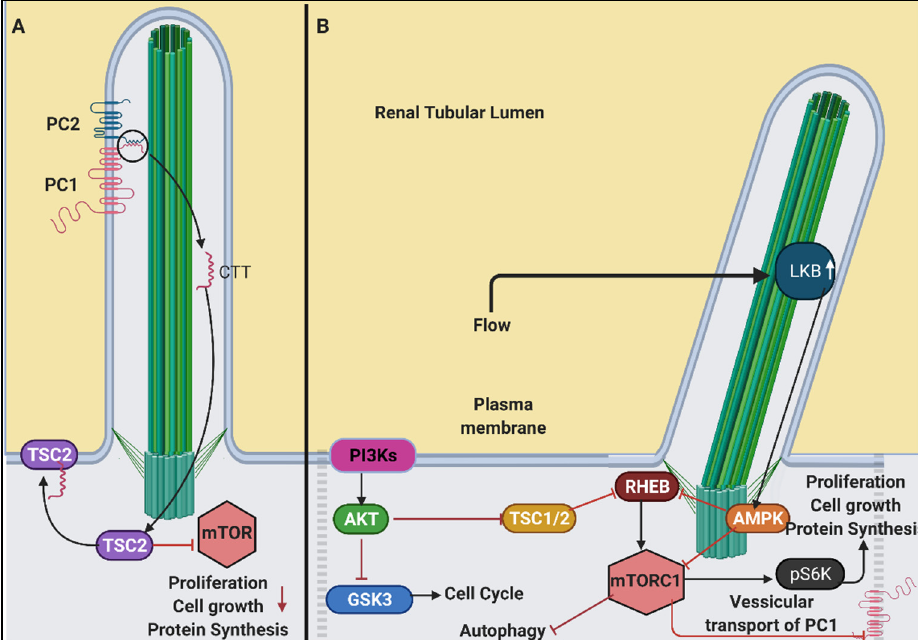
Figure 5. Regulation of phosphoinositide 3-kinases (PI3K)/ protein kinase B (Akt) / mammalian target of rapamycin (mTOR) signalling in renal cilia: ( A ) The PC1 CTT oversees the membrane trafficking of tuberculosis sclerosis complex 2 (TSC2), essential for homeostatic (negative) regulation of mTOR pathway. ( B ) Graphical representation of PI3K-AKT kinases and its link to mTOR pathway. Upon flow, the expression of tumor suppressor kinase Liver Kinase B1 (LKB1) increases which activates AMP-activated protein kinase (AMPK). AMPK negatively regulates mTORC1. Expression of downstream effectors like ribosomal protein S6 kinase B1 (pS6K) is enhanced upon mTOR activation. This leads to proliferation, cell growth, and increased protein synthesis. (Modified and redrawn using BioRender.com [150] ).